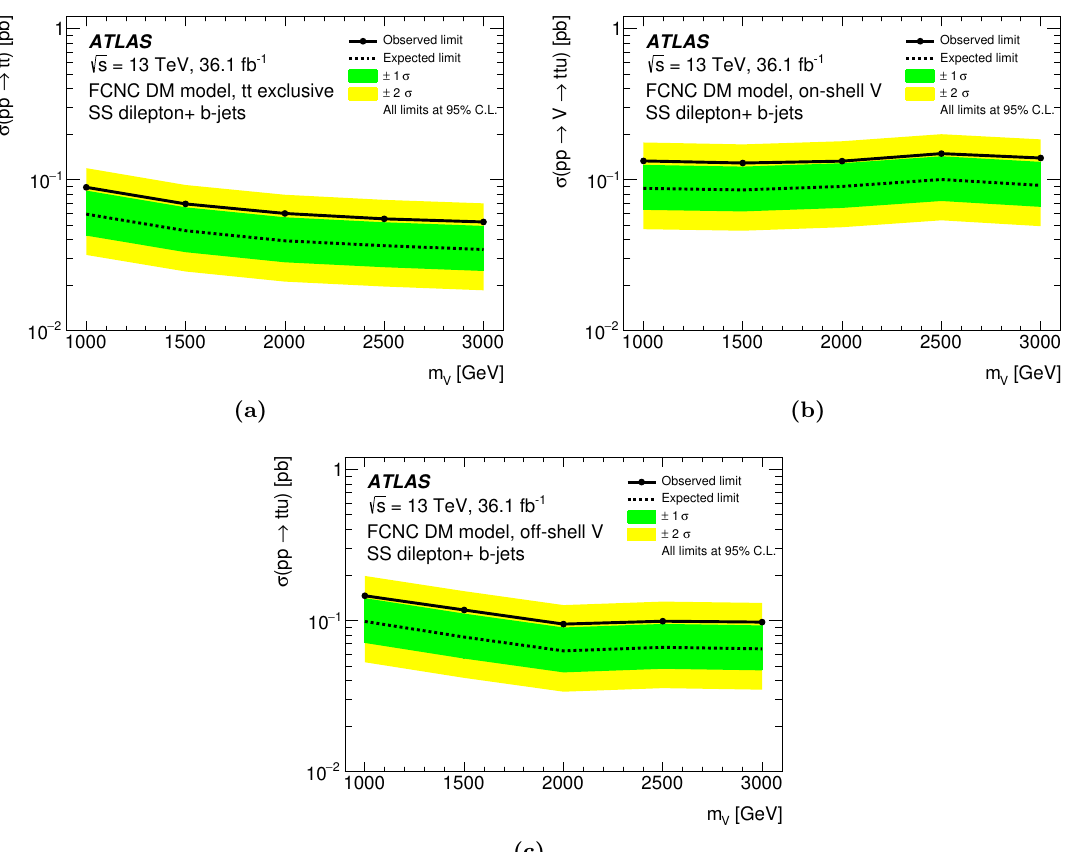
Figure 13 . Expected and observed 95% CL upper limits on the cross-section for (a) prompt tt production, (b) on-shell mediator, (c) o(cid:11)-shell mediator subprocesses of the same-sign top-quark pair production. In all plots, the expected 95% CL limits are shown with their deviation bands. Each subprocess is considered as a generic BSM signature and therefore no theory prediction is